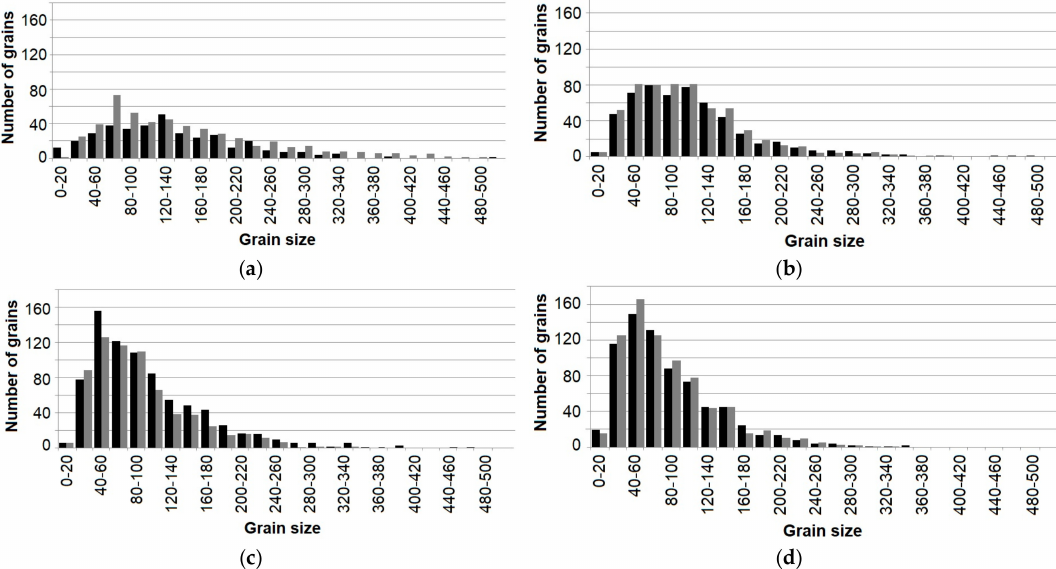
Figure 4. Microstructure of precipitation hardened alloys: ( a ) Mg10Gd; ( b ) Mg10Gd1Nd; ( c ) Mg10Gd1La; and ( d ) Mg10Gd1Nd1La (black bars: T4 and grey bars: T6-12